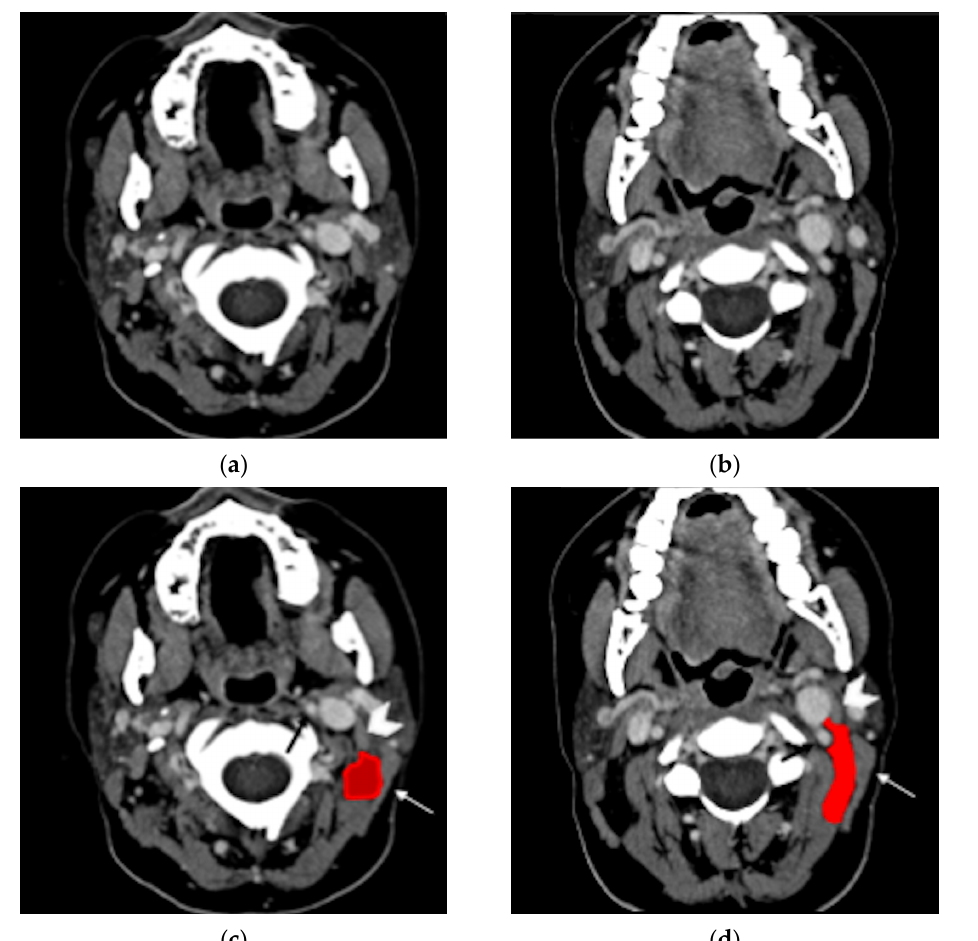
Figure 1. Normal anatomy, post-contrast axial CT ( a , b ). In the same images with annotations ( c , d ), the digastric muscle (white arrowhead) and the sternocleidomastoid muscle (white arrow) delimitate the posterior cervical space (red). The carotid artery can be identified nearby (black arrow).